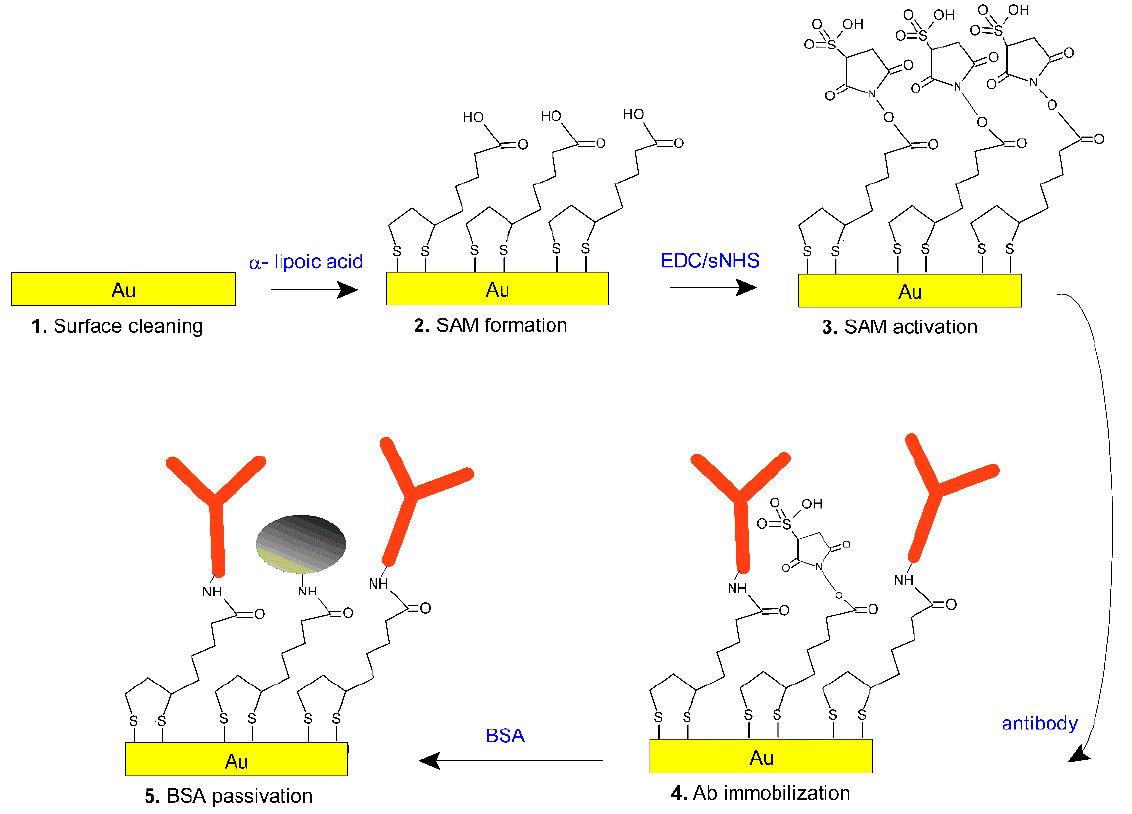
Figure 1. Scheme of the functionalization protocol: ( 1 ) gold cleaning with Argon plasma, ( 2 ) α -lipoic acid self-assembled monolayer, ( 3 ) activation with EDC/sulfo-NHS, ( 4 ) anti-amylase antibody immobilization and, finally, ( 5 ) surface passivation with bovine serum albumin (BSA).